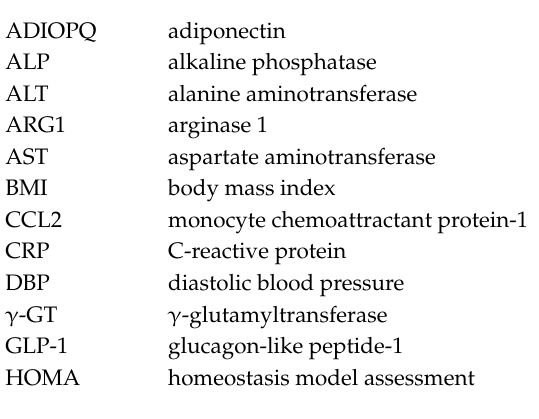
Figure S1: Gene expression levels of GLP1R in lean, obese NG and obese patients with T2D, Table S1: Sequences of the primers and TaqMan ®